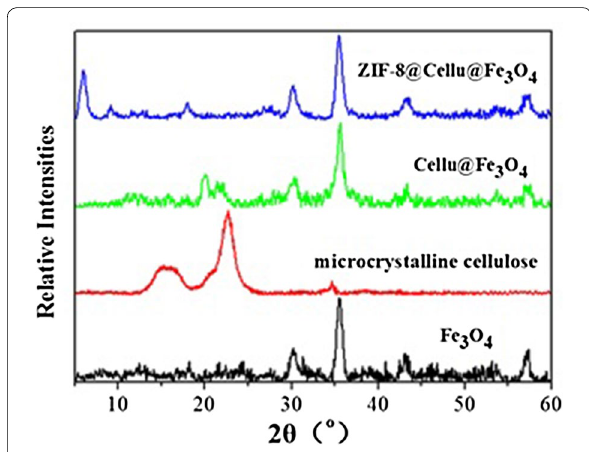
Fig. 1 The powder X‑ray diffraction patterns of ZIF‑8@Cellu@Fe 3 O 4 ,